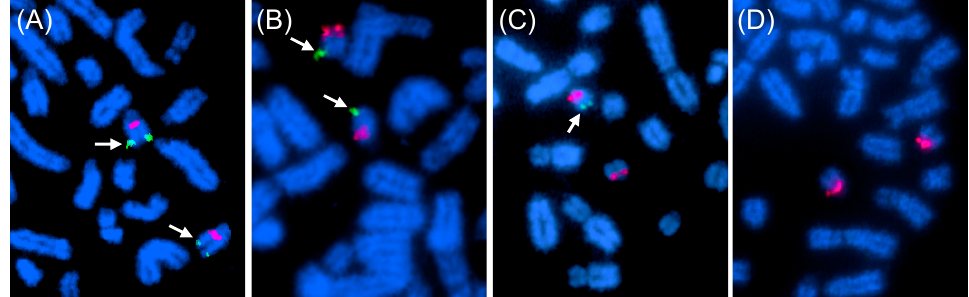
Figure 5. Deletion analysis by FISH with deletion-specific BAC 23N13 (green; arrows) and a control BAC 76H13 (red). (A) Normal male control Bravo with < 50 copies by qPCR and no deletion by FISH; (B) Normal male H395 with > 50 copies by qPCR and no deletion by FISH; (C) XX DSD horse H657 with < 50 copies by qPCR and heterozygous deletion by FISH; and (D) XY DSD horse H369 with homozygous deletion by qPCR and FISH.